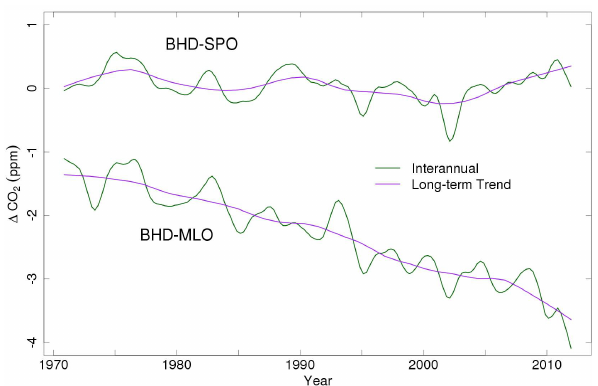
Fig. 10. BHD–SPO (top) and BHD–MLO (bottom) CO 2 differences in the interannual and trend components of the STL decomposition of the Baring Head, South Pole, and Mauna Loa records. The win- dow for the trend fits was 10yr, and for the interannual fits was 2yr. The fits include data prior to December 1972 from the Makara